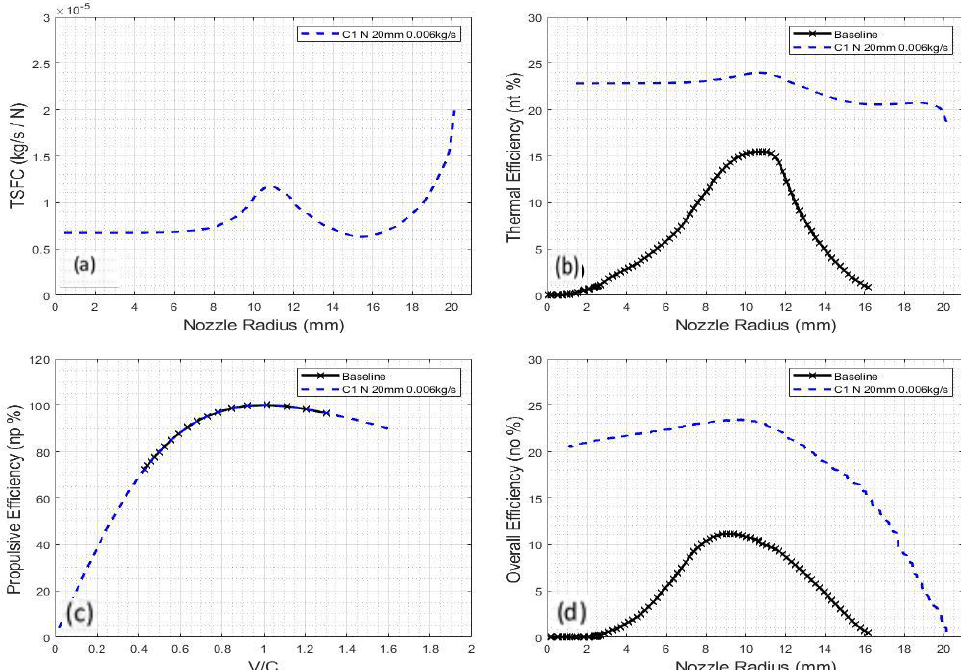
Figure 28. ( a ) Specific fuel consumption. ( b ) Thermal efficiency. ( c ) Propulsive efficiency. ( d ) Overall efficiency.